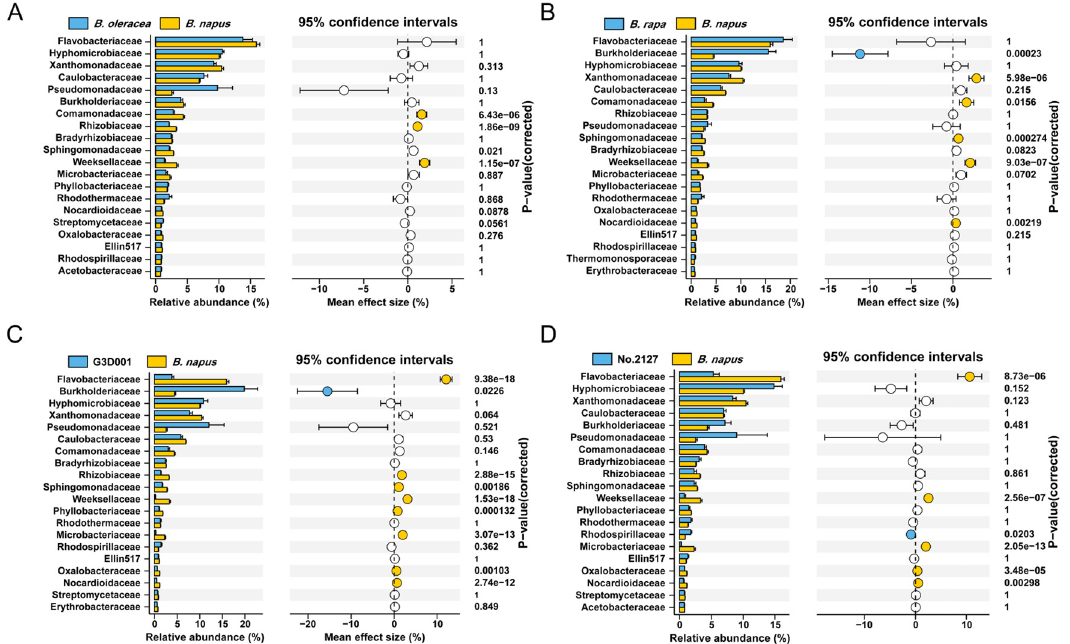
Figure 2. Differential abundance at the family level in B. napus , B. oleracea , B. rapa , and synthetic B. napus G3D001 and No.2127. Welch’s t -test and Bonferroni correction were performed between the rhizosphere microbiota of B. napus and B. rapa ( A ), B. napus and B. oleracea ( B ), B. napus and G3D001 ( C ), B. napus and No.2127 ( D ) at the family level, respectively. Each vertical bar represents the stand- ard error. The white color circle represents not significant, yellow represents enrichment in B. napus , blue represents enrichment in B. oleracea ( A ), B. rapa ( B ), G3D001 ( C ), No.2127 ( D ), respectively To determine the differential OTUs, edgeR based on the negative binomial distribu- tion was used to analyze the difference in 1950 OTUs in the rhizosphere microbiota of B. oleracea , B. rapa , and B. napus . Compared with those in B. napus , 346 OTUs (74.92% Pseu- domonas ) were enriched and 301 OTUs (28.22% Chryseobacterium and 20.74% Flavobacte- rium ) were depleted in B. oleracea (Figure 3A, Figure S5A); and 197 OTUs (74.92% Burkhold- eria ) were enriched and 163 OTUs (42.25% Chryseobacterium ) were depleted in B. rapa (Fig- ure 3B, Figure S5B). The differential OTUs in B. napus and synthetic B. napus were also analyzed. As a result, 402 OTUs (32.66% Burkholderia , 20.04% Pseudomonas , and 7.72% Rhodoplanes ) were enriched and 267 OTUs (27.05% Flavobacterium and 12.13% unclassified Xanthomonadaceae ) were depleted in G3D001 (Figure 3C, Figure S5C); while 347 OTUs (18.87% Pseudomonas , 13.52% Burkholderia , 12.15% Rhodoplanes ) were enriched and 282 OTUs (24.12% Flavobacterium and 12.32% unclassified Xanthomonadaceae ) were depleted in No.2127 (Figure 3D, Figure S5D). Relative to B. napus , the number of differential OTUs with higher abundance (log2 relative abundance >10) was 15 in B. oleracea, 12 in B. rapa, 84 in G3D001, and 84 in No.2127 (Figure 3). These results indicated that the rhizosphere dif- ferential OTUs among B. oleracea , B. rapa , and B. napus were mainly related to some rare species, while B. napus and synthetic B. napus were not only different in rare species but also in some OTUs with high abundance. A significant overlap of differential OTUs was found between G3D001 and No.2127, among which 222 OTUs were co-enriched and 220 OTUs were commonly depleted in the two synthetic B. napus lines (Figure S6), indicating that synthetic B. napus G3D001 and No.2127 have similar composition of rhizosphere mi- crobiota.